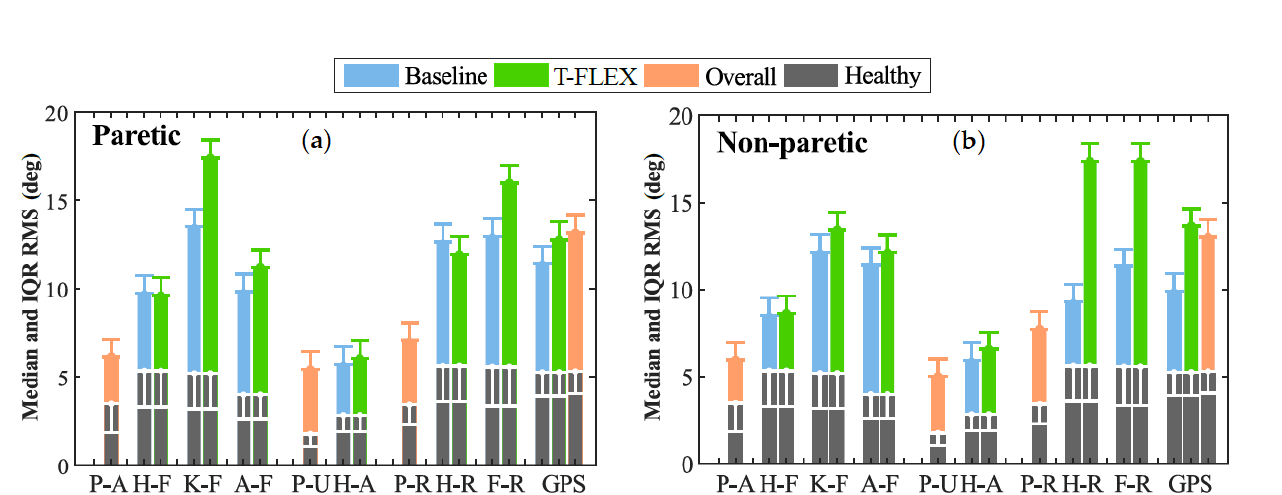
Figure 6. Movement analysis profile. Each column represents one of the kinematic variables such as P-A (Pelvis Anterior- posterior), H-F (Hip Flexion-extension), K-F (Knee Flexion-extension), A-F (Ankle dorsi-plantarflexion), P-U (Pelvic Up-down), H-A (Hip Abduction-Adduction), P-R (Pelvic Rotation), F-R (Foot Rotation), and GPS (Gait Profile Score). The height of the bar indicates the median and IQR RMS value during the trial. The gray columns at the bottom denote the mean values for a healthy gait pattern obtained from [29]. Those values are used as the reference to compare the unassisted condition (blue bars) and assisted gait (green columns).